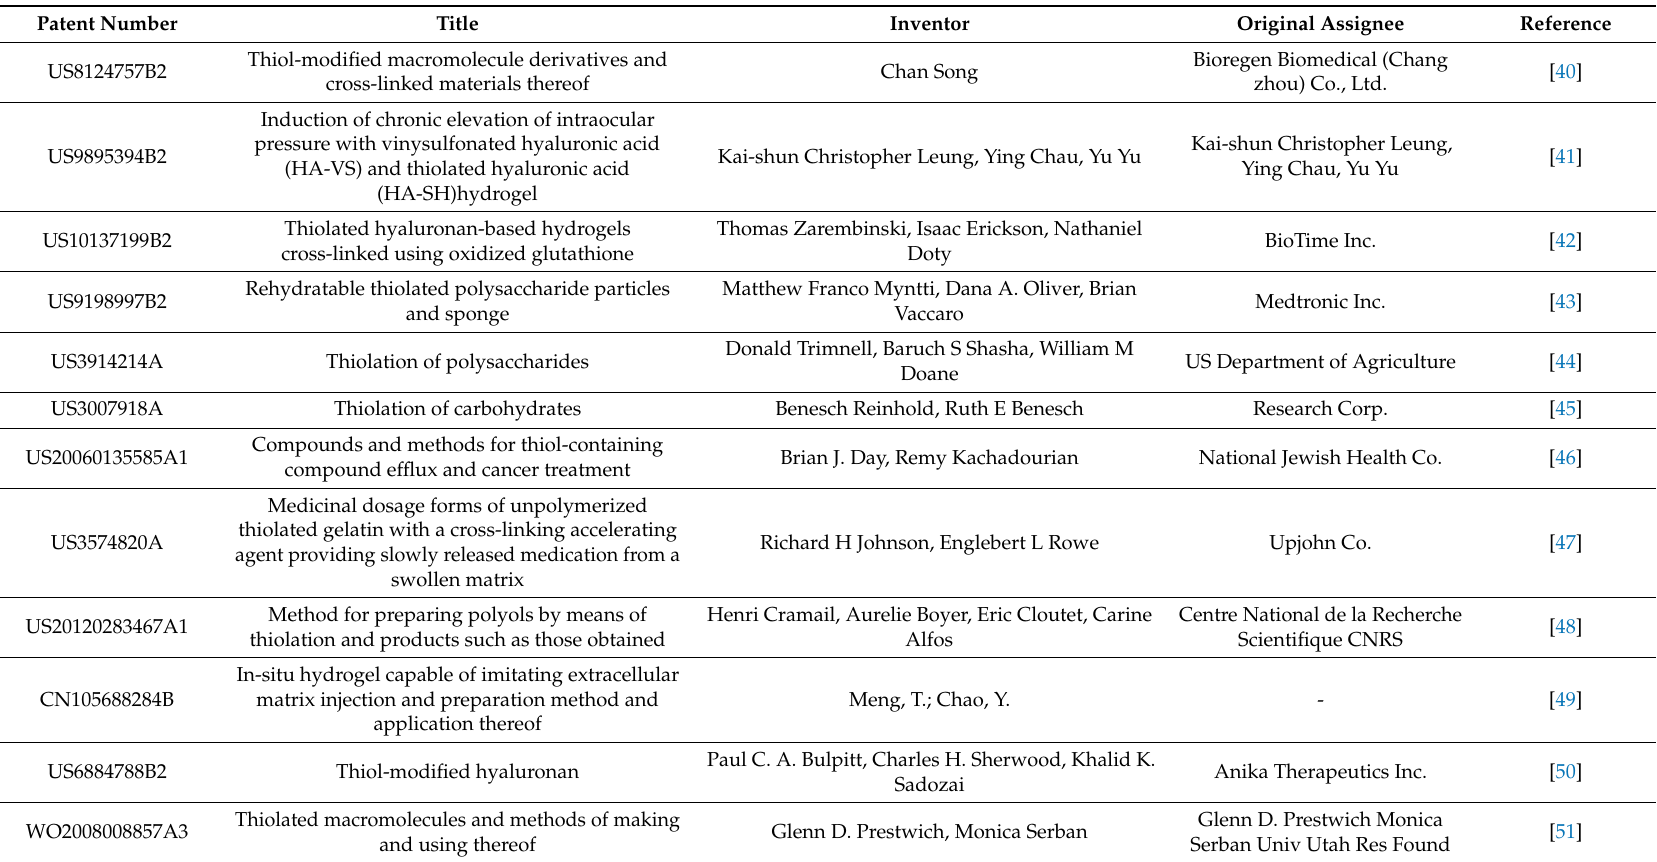
Table 3. Patents filed by researches on thiolated